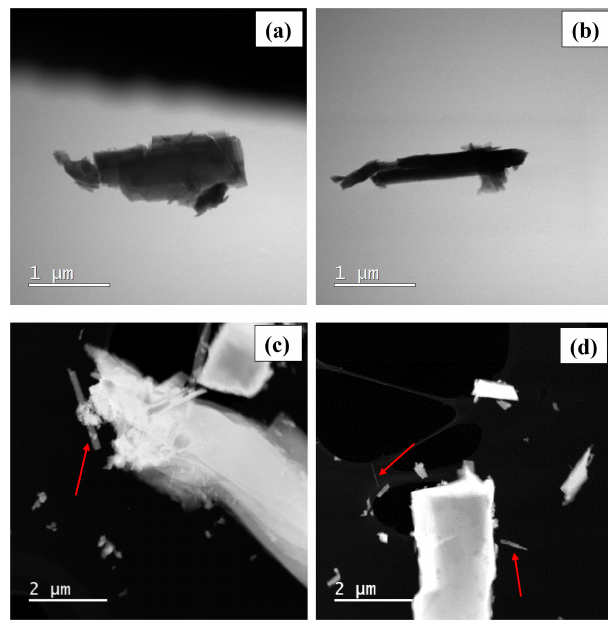
Figure 15. (a) STEM picture of the starting (0 ◦ ) and (b) final po- sition (120 ◦ ) of the particle used for the three-dimensional tomo- graphic reconstruction. (c, d) Dark-field STEM pictures showing the presence of nano-sized EMPs (red